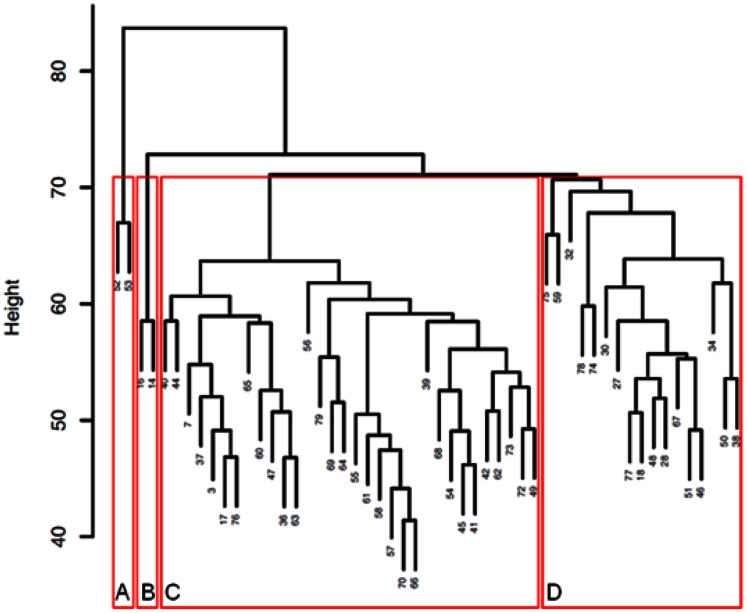
Cluster analysis.Clustering of the 53 patients was performed according to their CKD273 pattern using an average linkage clustering and standard Euclidean distances to assign the patients to clusters.